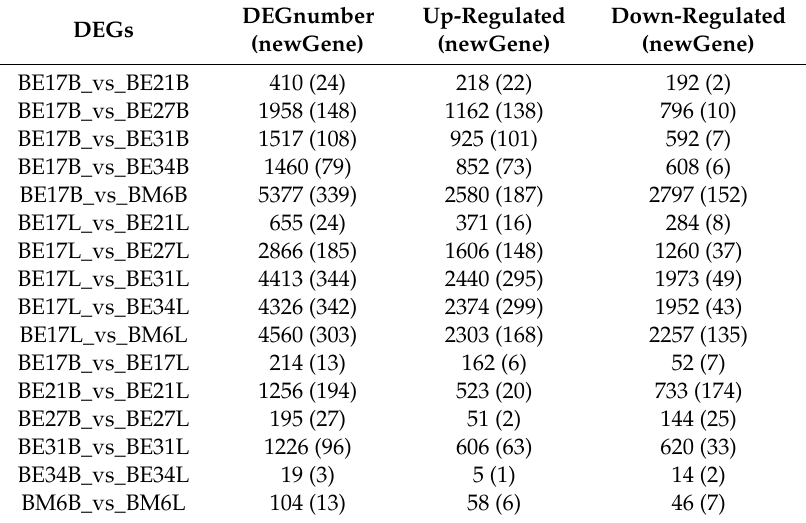
Table 5. Statistical results of di ff erentially expressed